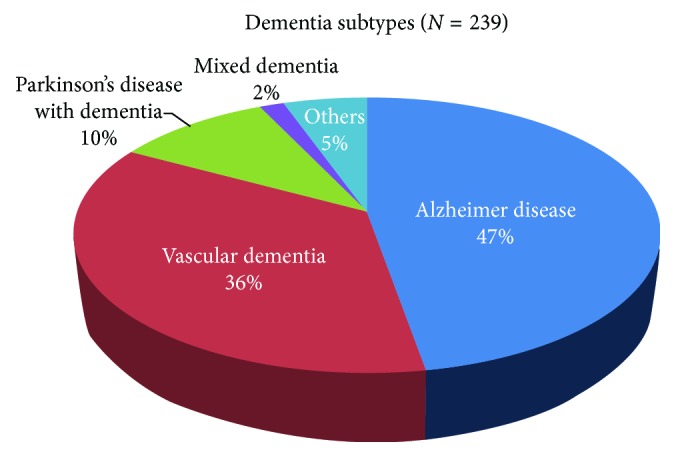
Dementia subtypes.